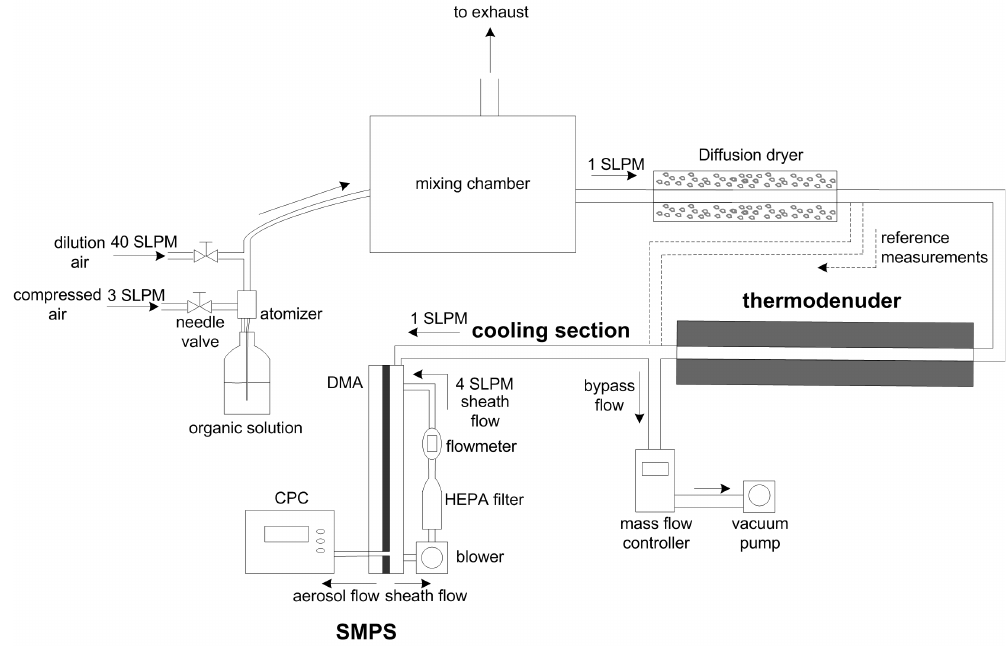
Fig. 1. Schematic of experimental setup.